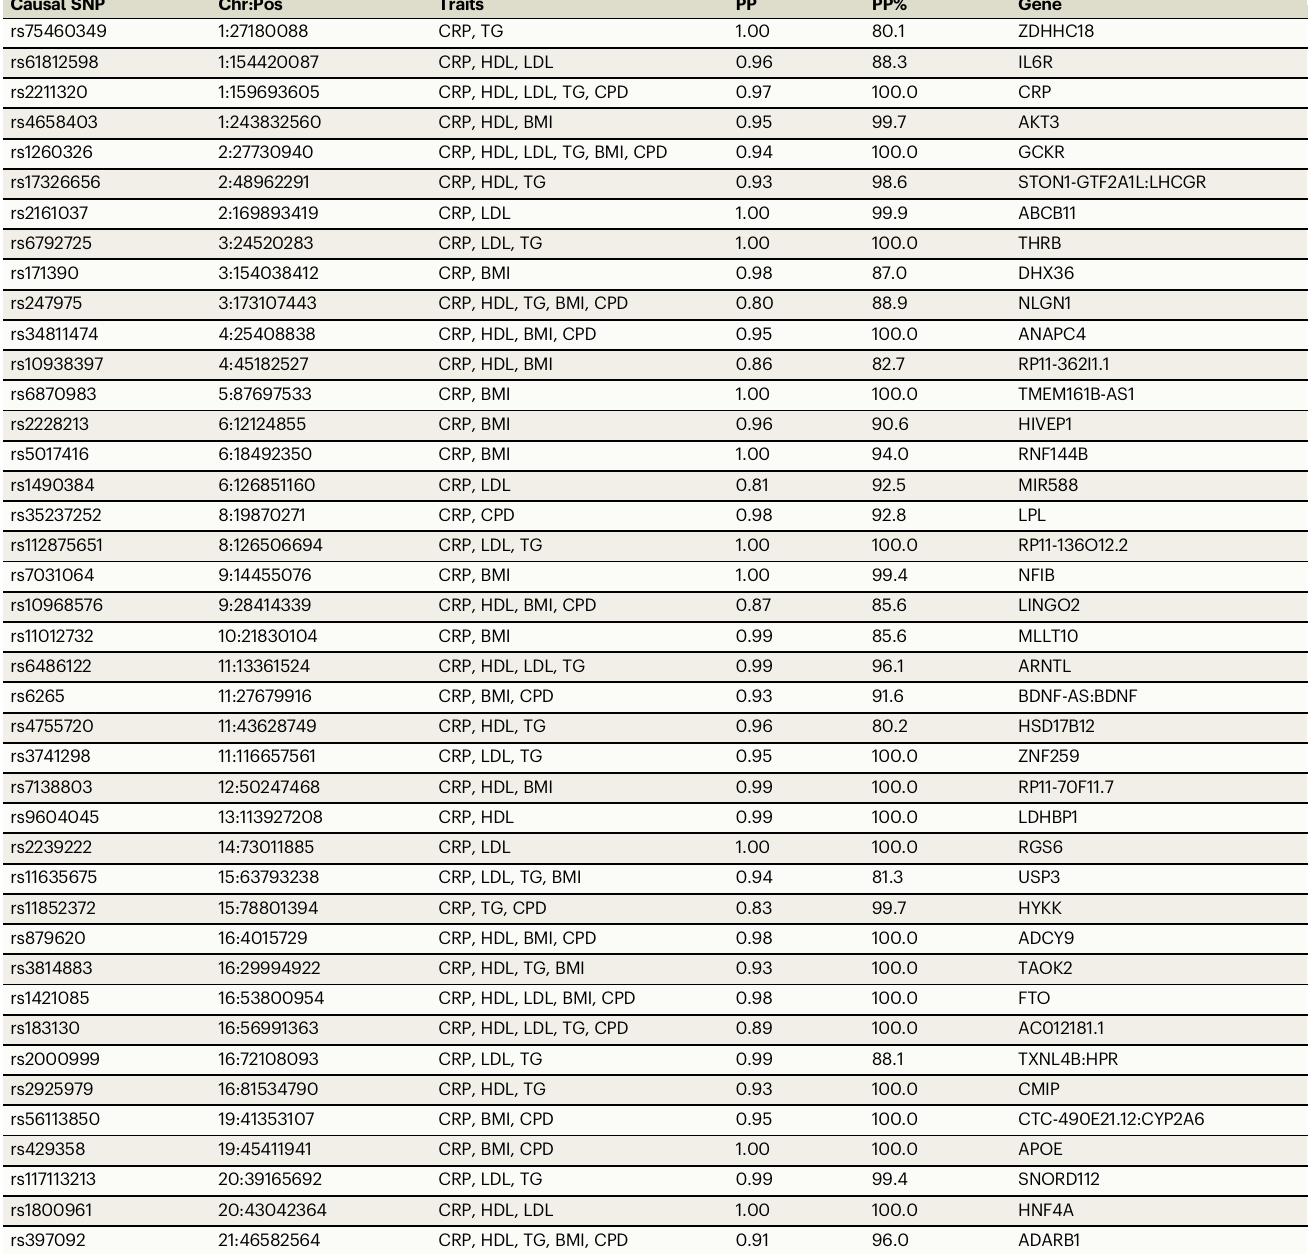
Table2 | C-reactive protein top signals which colocalize (PP > 0.8)with anycombinationofthe other examined traitsexplaining at least the 80% of the shared association Causal